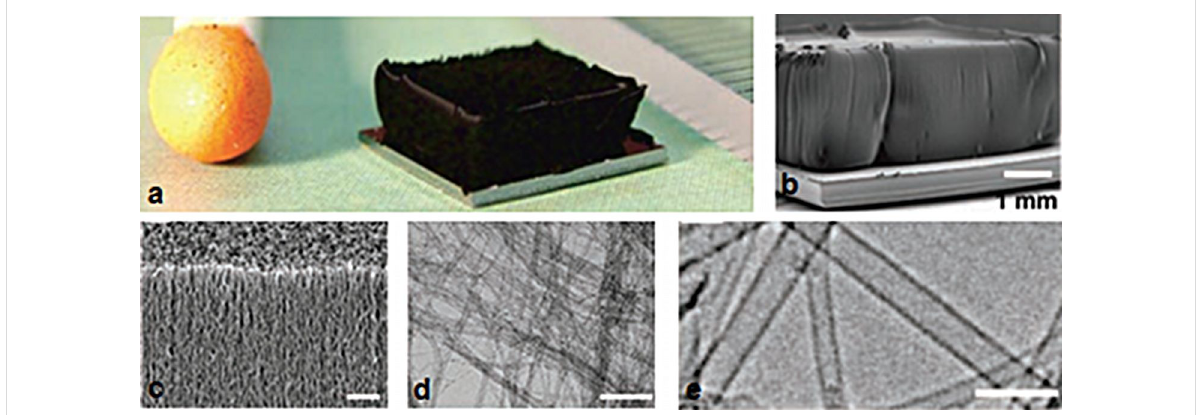
Figure 3: SWCNT forest grown with water-assisted CVD. (a) Picture of a 2.5 mm tall SWCNT forest on a 7 mm by 7 mm silicon wafer. A matchstick on the left and ruler with millimeter markings on the right is for size reference. SEM images of the same SWCNT forest with scale bars of 1 mm (b) and 1 μ m (c), respectively. TEM images of the nanotubes with scale bars of 100 nm (d) and 5 nm (e), respectively. Adapted with permission from [26]. Copyright 2004 American Association for the Advancement of